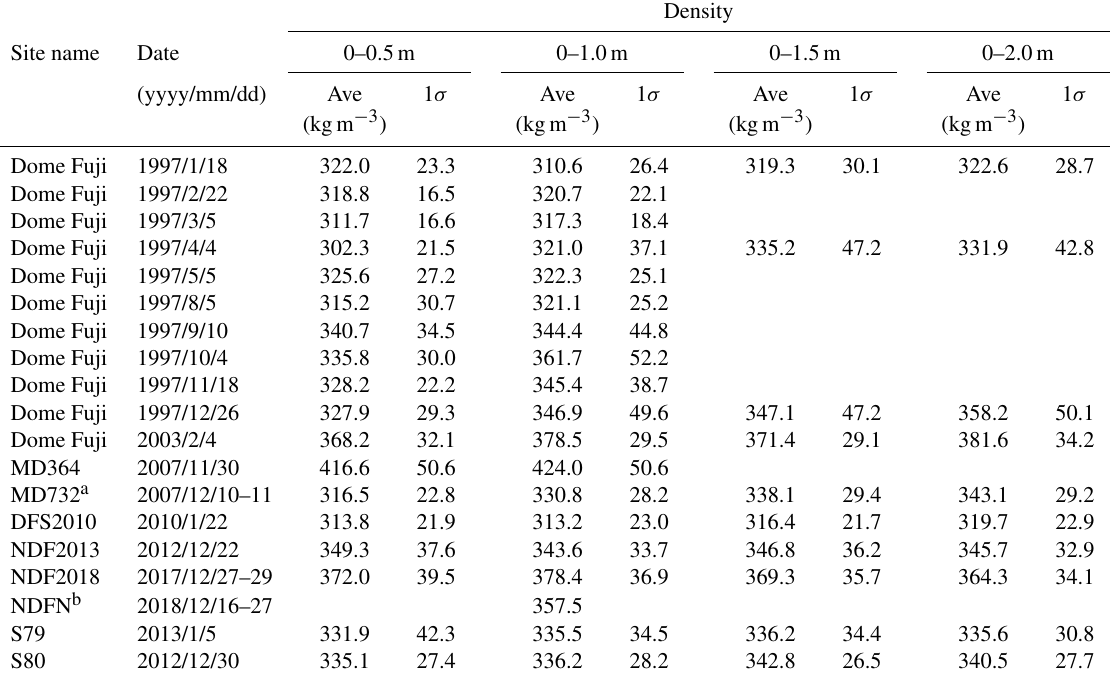
Table 2. Surface density from snow pits.